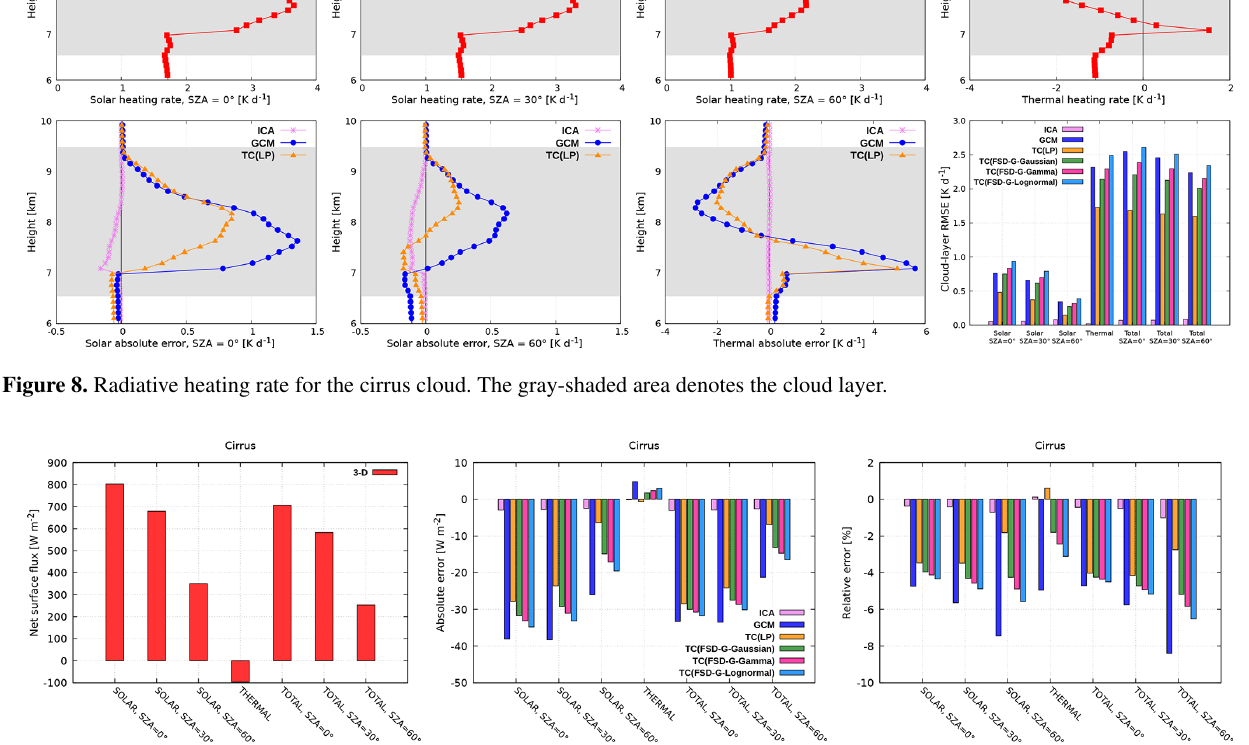
Figure 9. Net surface radiative flux for